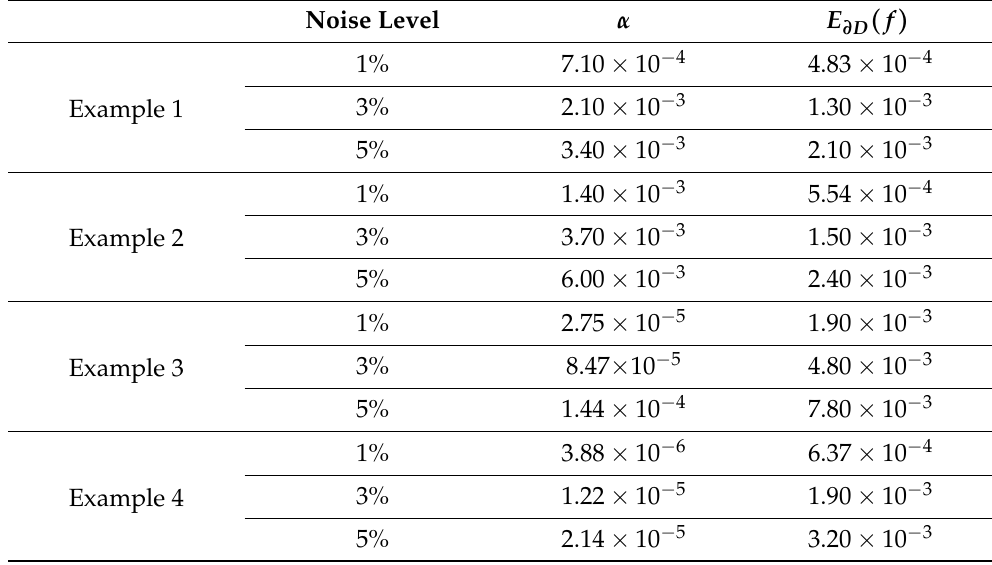
Table 1. The total errors with the percentages of noise increasing from 1% to 5% on ∂ D for Examples 1–4.